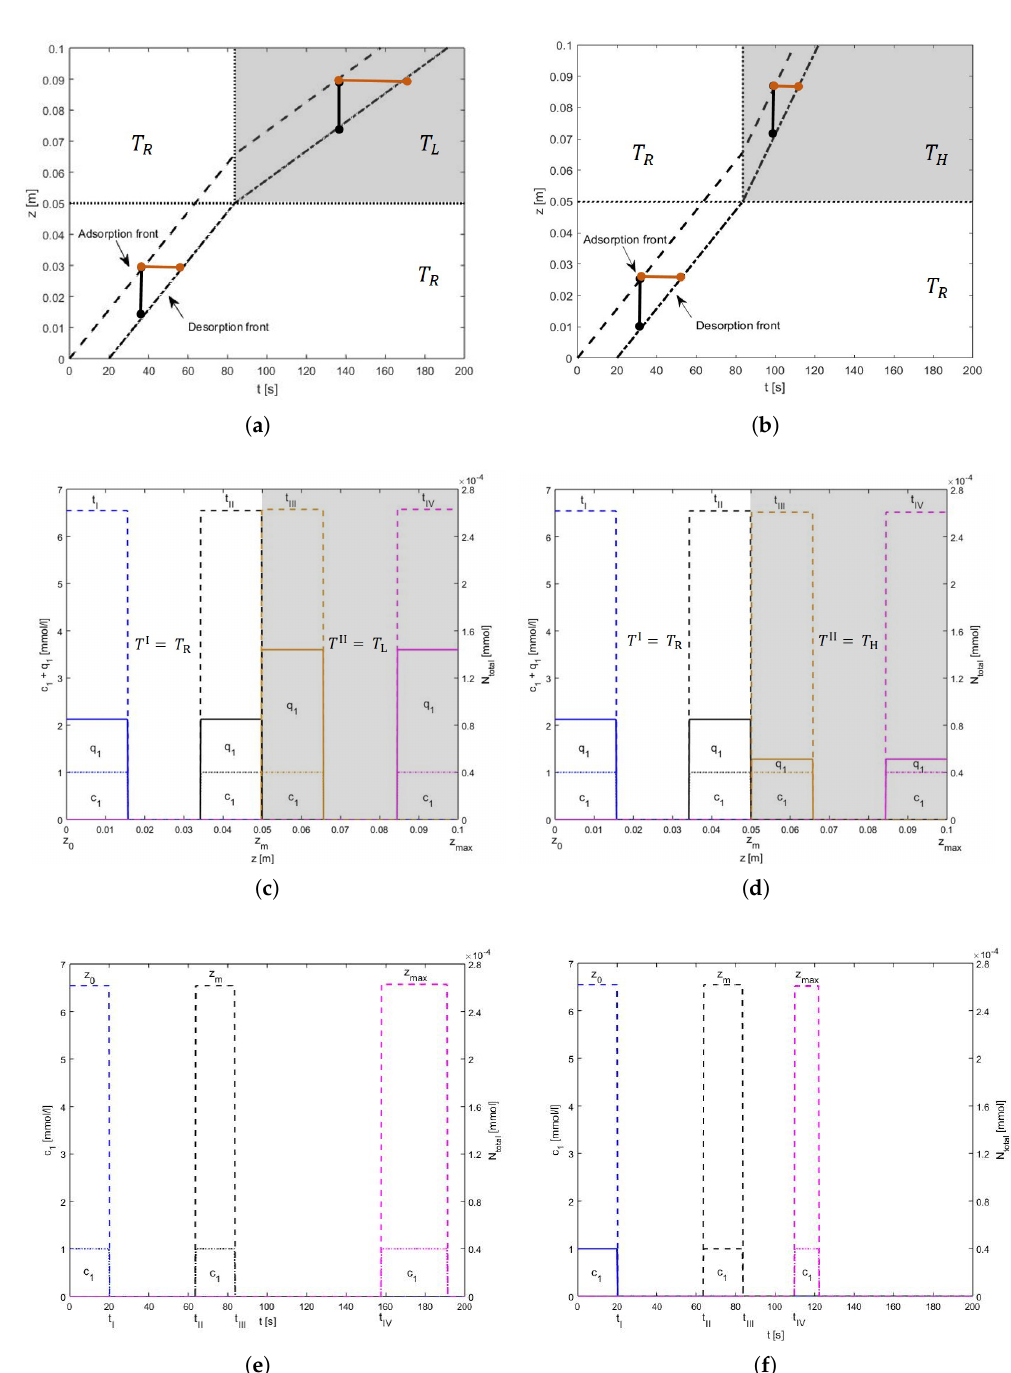
Figure 6. Illustration of the solution behavior for both cooling and heating of Type II: Concentrations and mass are again plotted along the left and right axes, respectively. ( a ) The grey color is representing segment II with low temperature. The temperature is switched from reference to low at time t 1 when the desorption front of the pulse also enters segment II. The space-bandwidth is marked by black color and stays unchanged. The time-bandwidth of the pulse is marked by orange color which becomes longer. ( b ) Here, the grey color is representing segment II with high temperature. Unlike case (a), here the time-bandwidth decreases. ( c , d ) are z -plots for cooling and heating respectively. Whereas. ( e , f ) are t -plots for cooling and heating